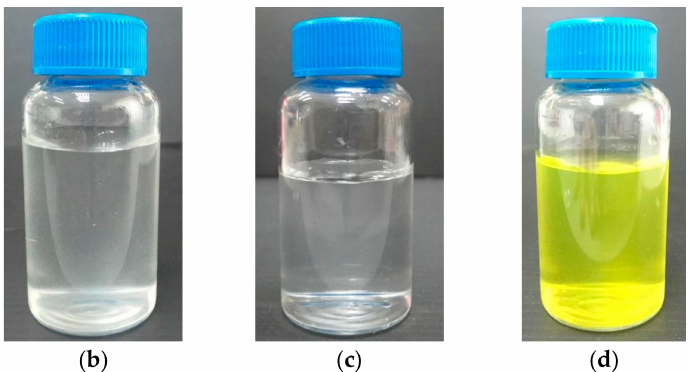
Figure 1. Photographs of aqueous suspension of ( a ) schematic diagram illustrating the reaction of conjugating fluorescein isothiocyanate (FITC) onto cellulose nanocrystals (CNC). Photographs of aqueous suspension of ( b ) 500 µ g / mL cellulose nanofibre (CNF), ( c ) 100 µ g / mL CNC, and ( d ) 100 µ g / mL FITC-CNC.